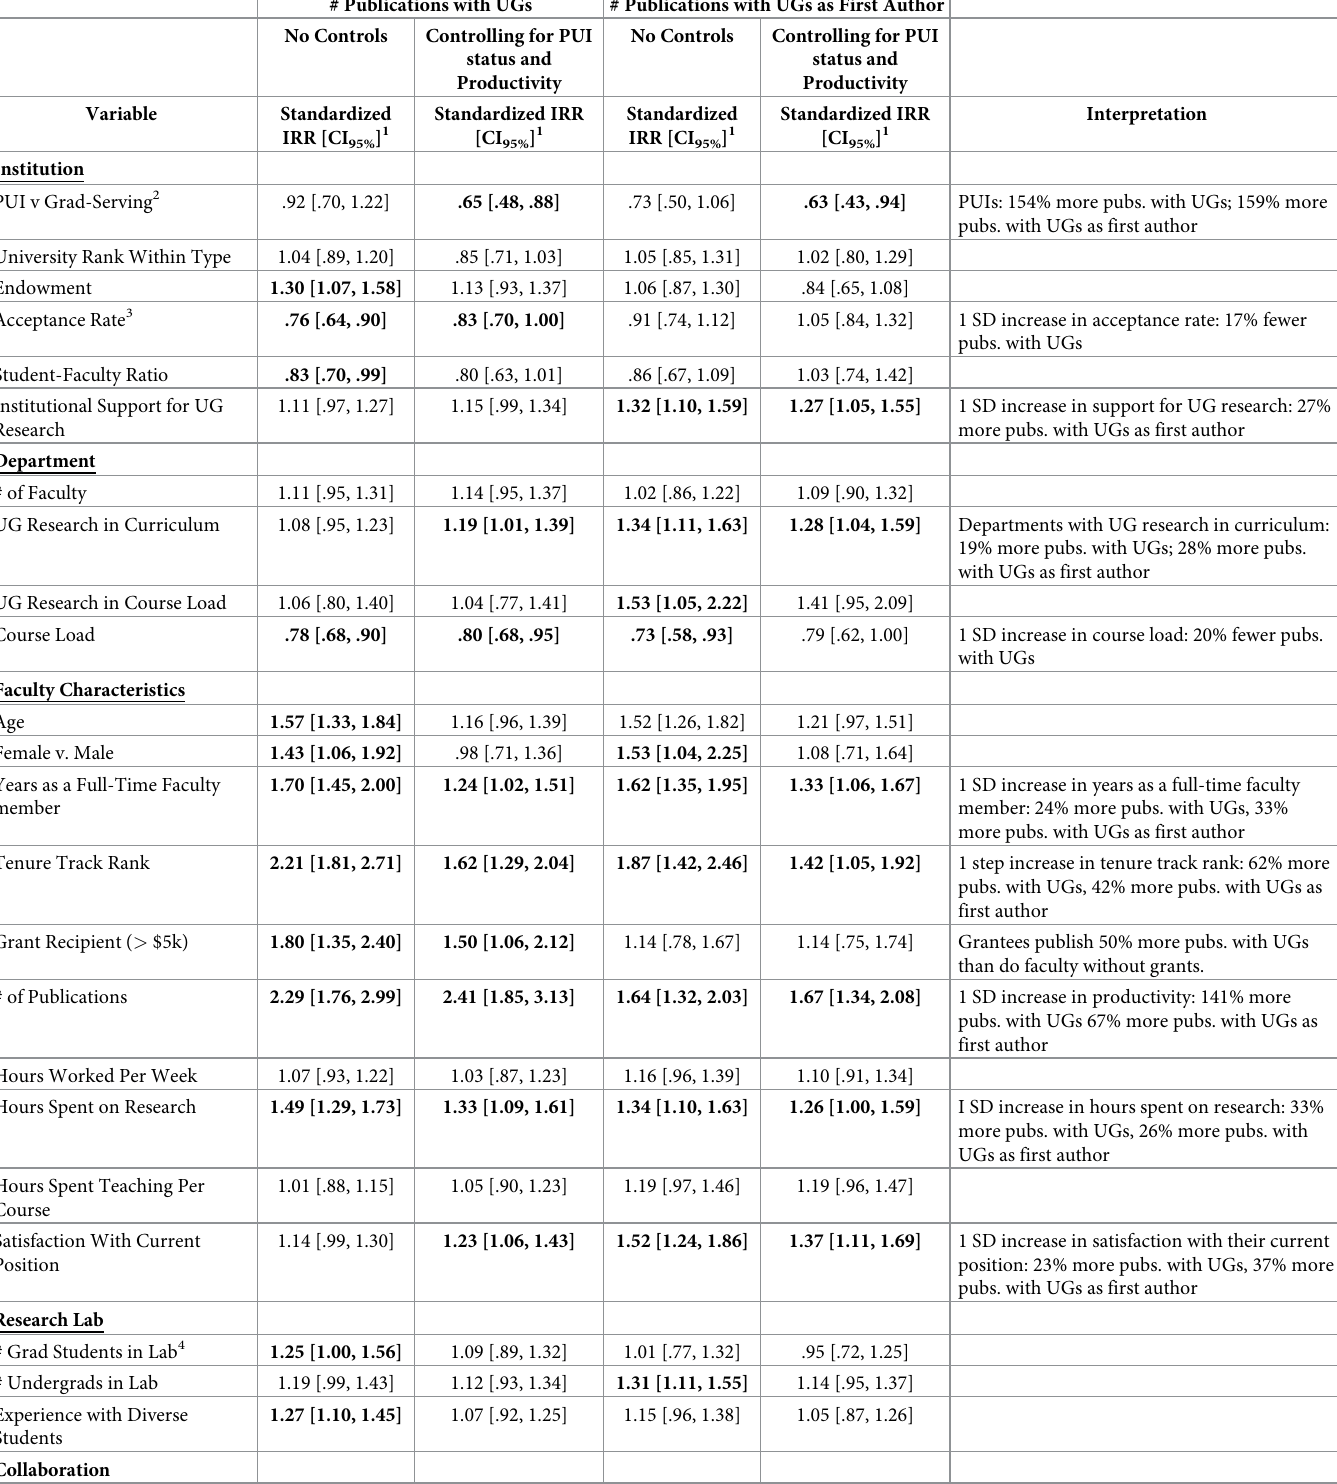
Table 3. Negative binomial regressions examining predictors of publications with undergraduate (UG) authors (left estimates) and publications with UG first authors (right